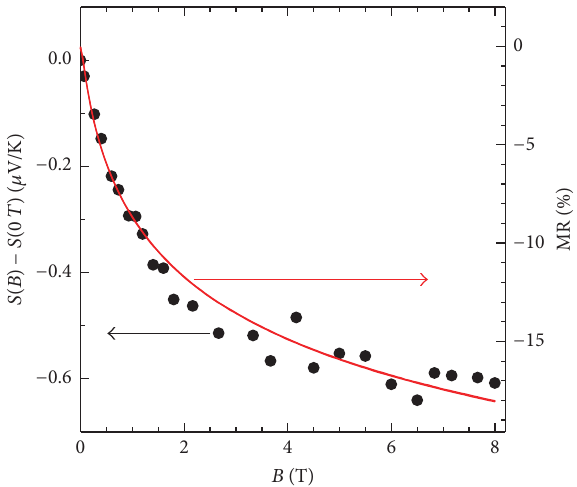
Figure4:Plotofthethermopowerdifference, 𝑆(𝐵)−𝑆(0 T ) (leftaxis, circles), and the magnetoresistance (right axis, solid curve) from Sr 2 FeMoO 6 against the applied magnetic field at 77